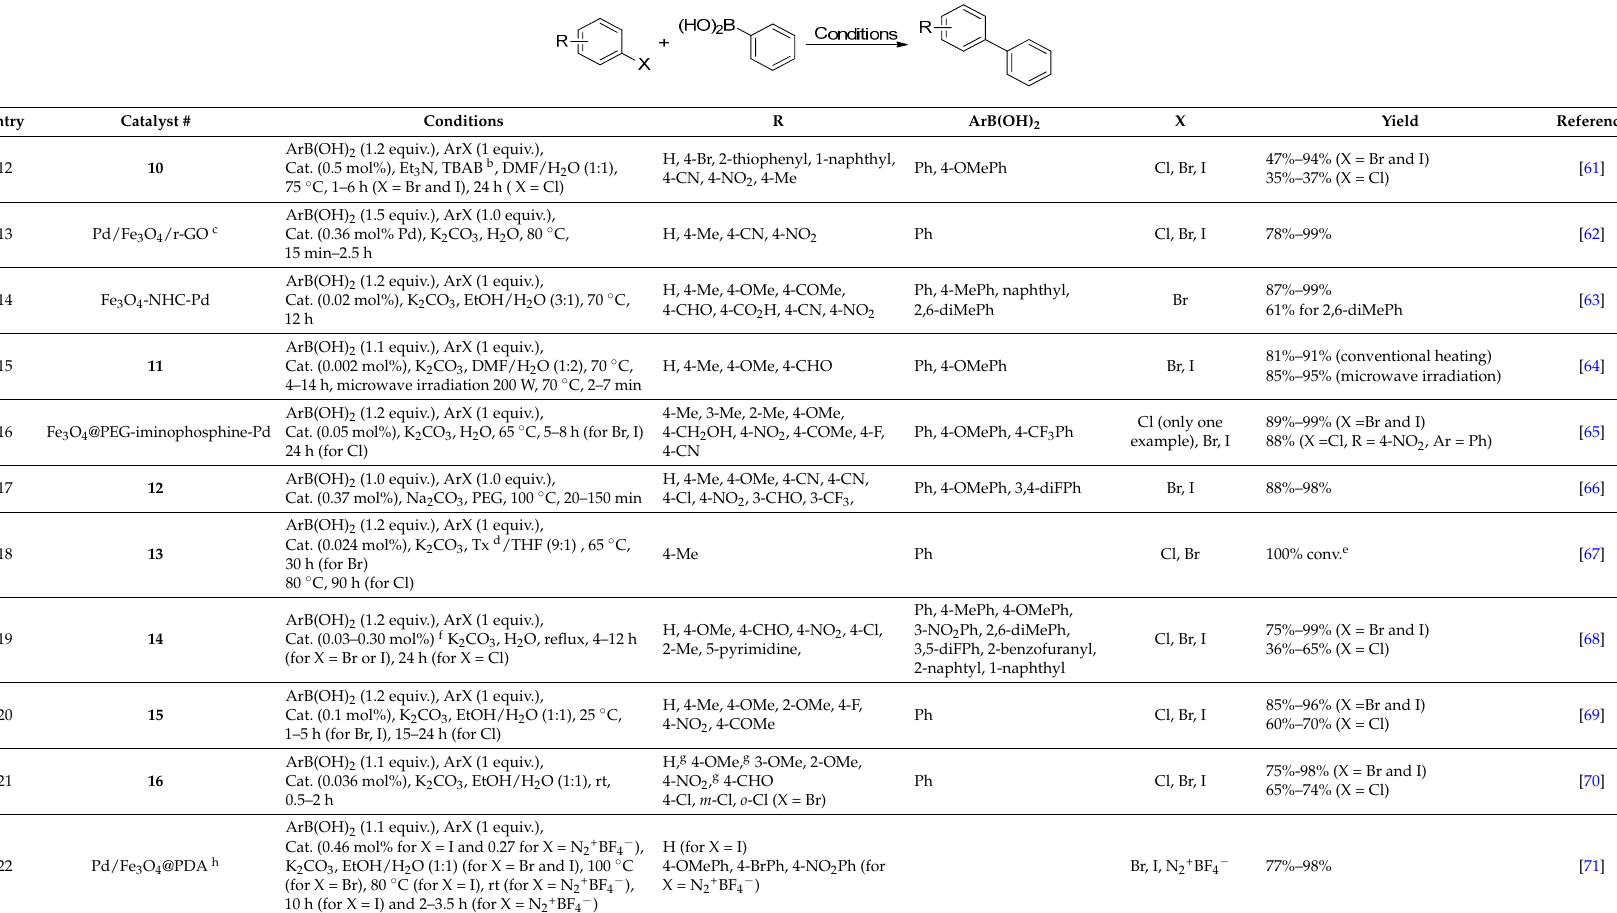
Table 2. Use of palladium catalyst chelated to magnetic nanoparticles as catalysts for Suzuki–Miyaura cross ‐